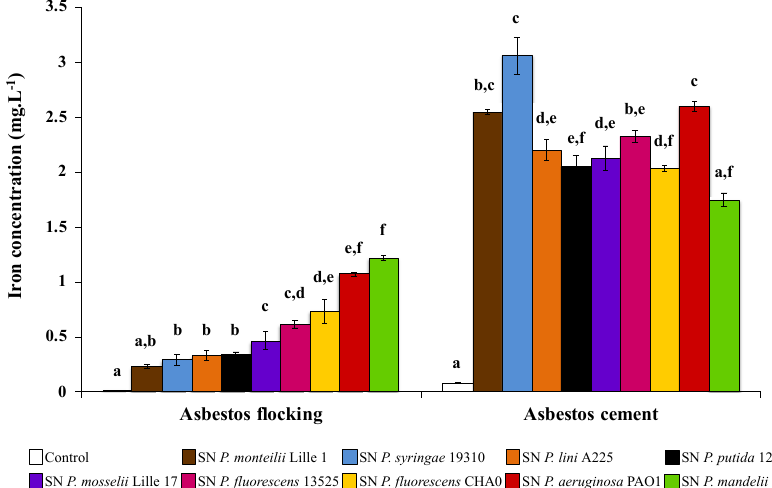
Figure 6. Concentration of iron dissolved from asbestos flocking or asbestos-cement in the presence of 100 µM of various pyoverdine-containing supernatants (SN) after 24 h of contact. Error bars indicate the standard errors of the means of three or five replicates. Bars with the same letter are not significantly different ( p ≥ 0.05, Kruskal–Wallis test, three or five replicates). Adapted from David et al. [72,80].